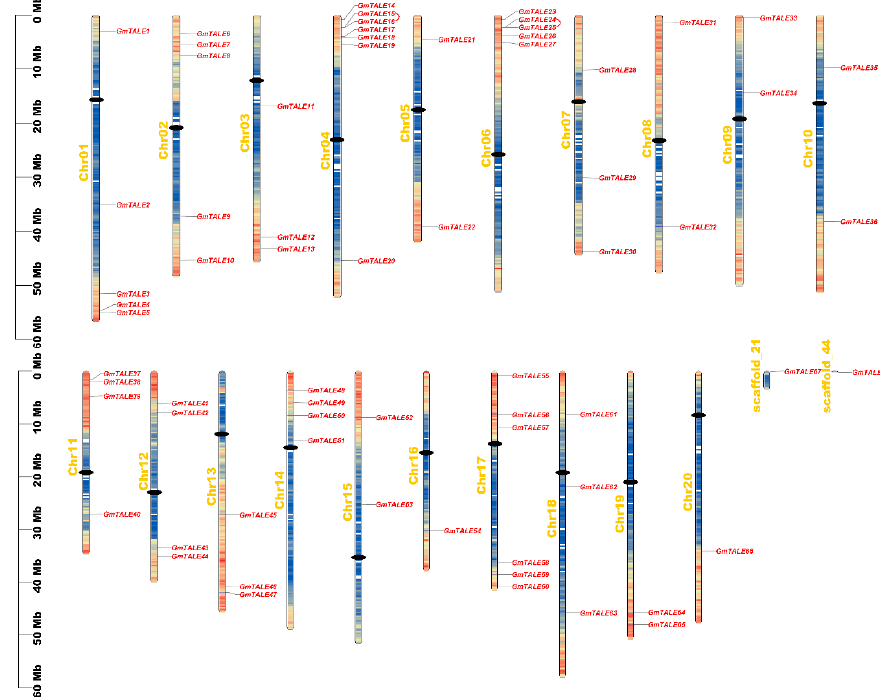
Figure 3. Chromosomal distributions of GmTALE genes. Chromosomal names were placed at the left. The scale on left is in megabases (Mb). Gradient colors from red to blue that attached to soybean chromosomes were corresponding from high to low gene density by setting the estimating hereditary interval as 300 kb. The red color represented high gene density, and the blue color represented low gene density. The blank regions on chromosomes were the genetic regions that lacked gene distributing information. And the centromeres were depicted with black dots. Besides, the tandemly duplicated GmTALE gene pairs were linked by red